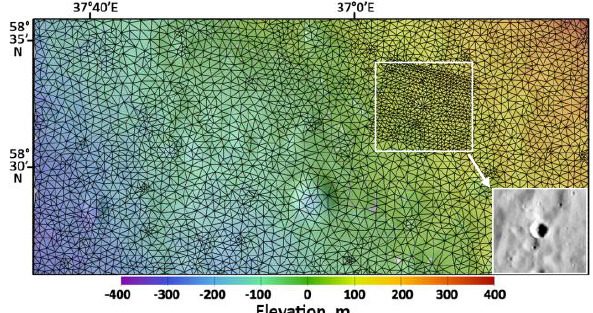
Figure 8. Triangulated Irregular Network generated from manually measured tie-points along structure lines of Mercury terrain objects (in white box – a studied flat-floor crater). Background: derived DTM with resolution 50 m/pixel and elevation accuracy ±10 m based on MESSENGER MDIS NAC